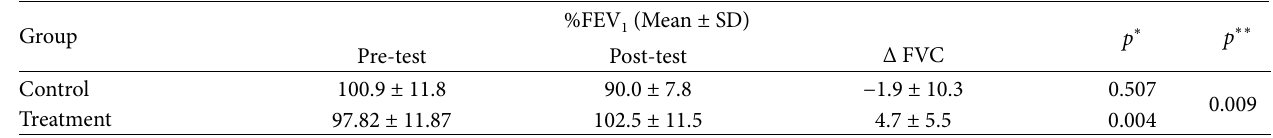
before and after treatment. 1